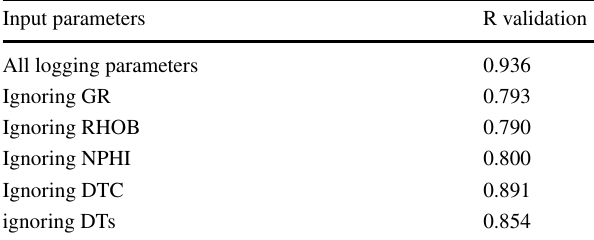
Table 2 Input parameters impact on the RF model performance Table 3 RF and DT model’s best